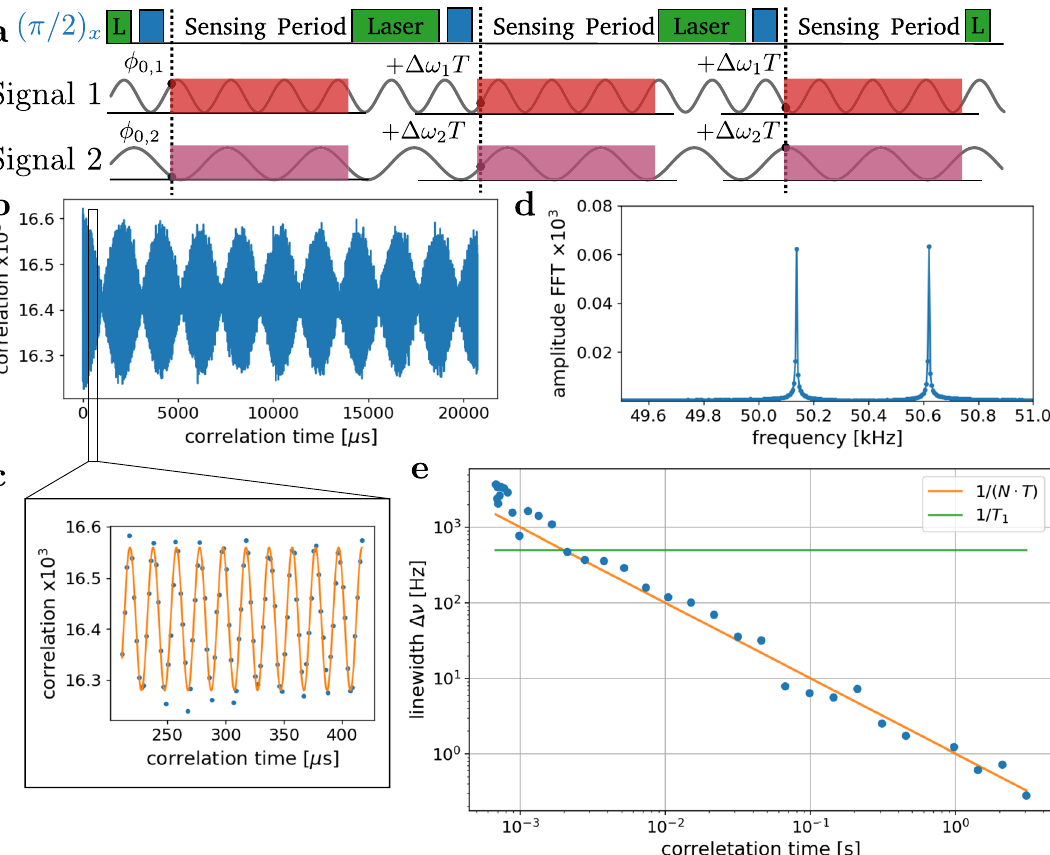
Fig. 2 Heterodyne detection of microwave fi elds by phase-dependent evolution. a The NV center is initialized and readout with a green laser pulse (green), the external reference prepares the rotating frame by a π /2 pulse (blue) in which the signals (1 & 2) are measured. The phase of the external source evolves relative to the signal 1 ( Δ ω 1 = 2 π ⋅ 50.138 kHz) and signal 2 ( Δ ω 2 = Δ ω 1 + 2 π ⋅ 482 Hz) with Δ ω 1,2 Δ t between two measurements. In ( b ) autocorrelation of the measured photon counter time trace. The beating between the two signals can be clearly recognized, consisting of fast oscillations shown in ( c ). d Fourier spectrum of the autocorrelation. In ( e ) linewidth of the FFT peak as a function of the correlation length. The 1/( N ⋅ T ) scaling of the linewidth shows the Fourier limited linewidth for the applied sinusoidal signal. For the longest correlation time of 3 seconds, a linewidth of 300 mHz is extracted, well below the sensor lifetime of 1/ T 1 ≈ 500